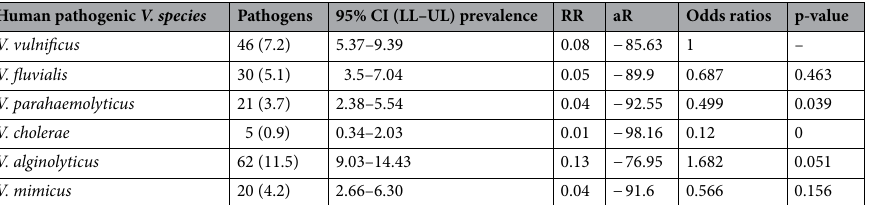
Table 4. Distribution of six human pathogenic Vibrio spp. by PCR, Risk estimate (relative risk and attributable risk), odds ratios in surface waters of greater Bushenyi Districts. CI confidence interval, LL lower limit, UL upper limit, RR relative risk, aR attributed risk.